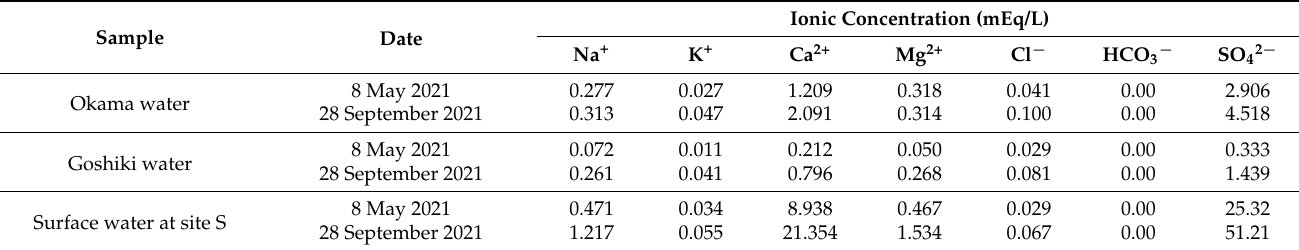
Table A2. Ionic concentrations in mEq/L for the stiff diagrams of Figure